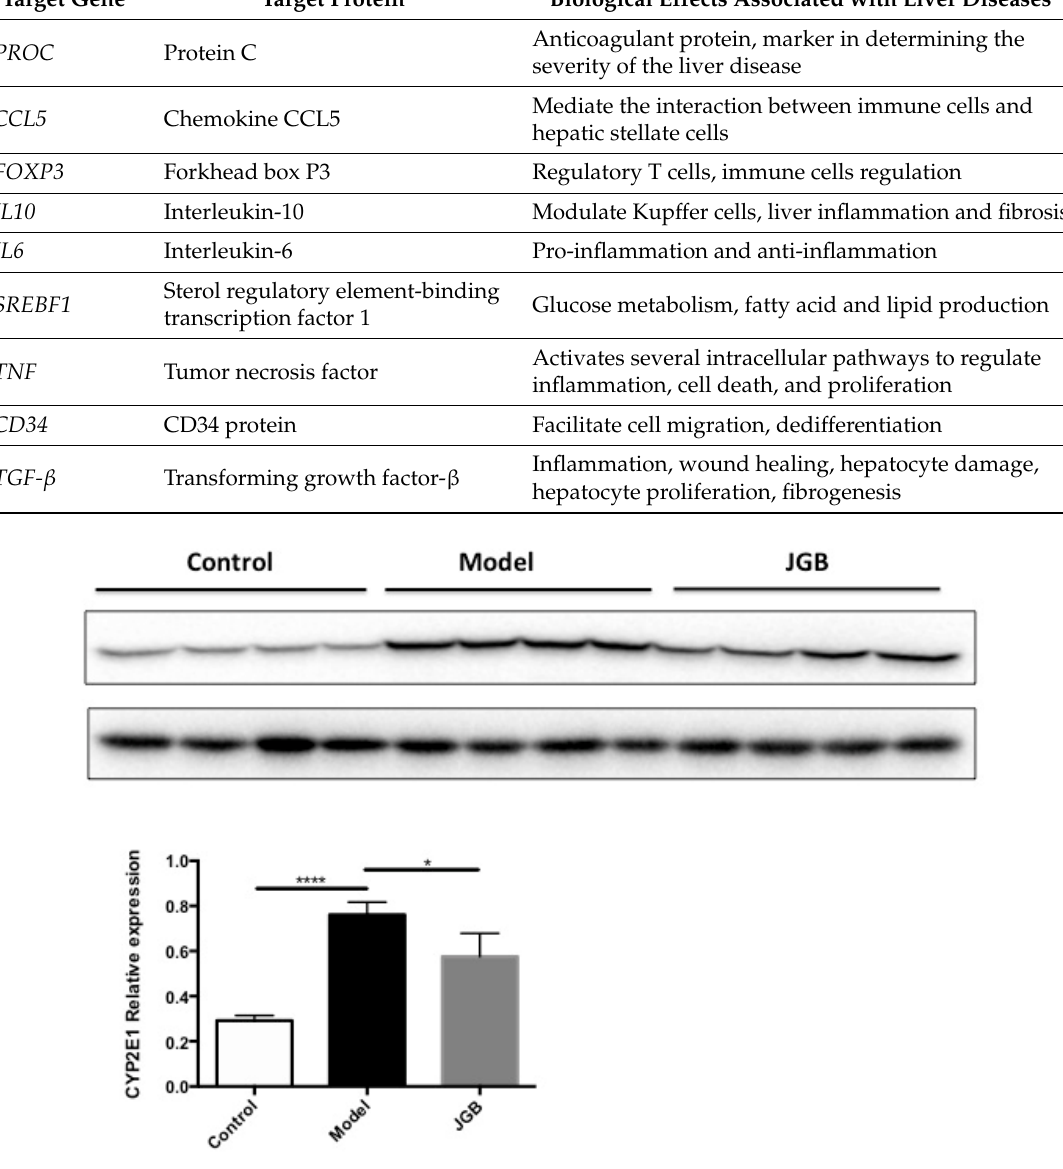
Figure 7. The hepatic protein level of CYP2E1 induced by ethanol was significantly decreased by JGB treatment. * p < 0.05, **** p < 0.0001 when compared with model group.